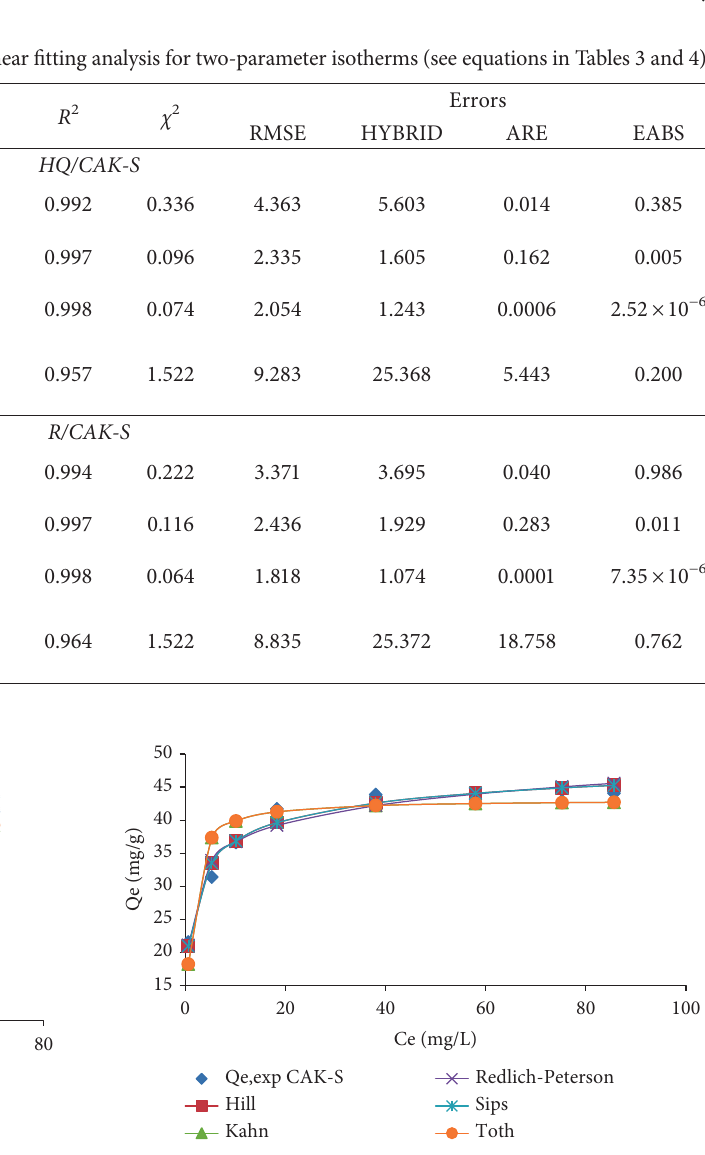
Figure 10: Nonlinear plot of three-parameter adsorption isotherm models of R by